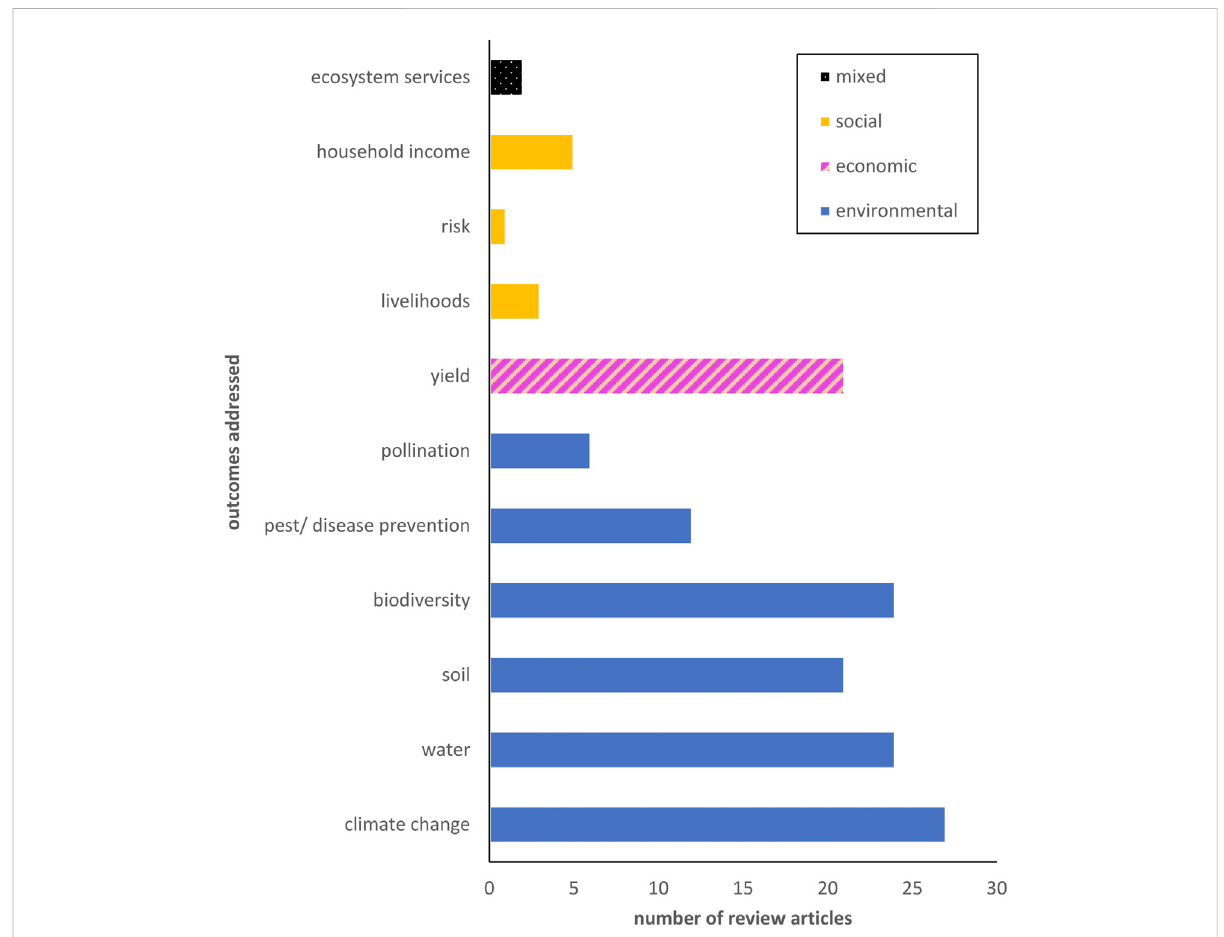
FIGURE 5 Frequency distribution of outcomes examined by the 64 review articles (some studies cover more than one outcome). Environmental outcomes related to climate change, water and biodiversity were most frequently examined. Productivity aspects of agroforestry